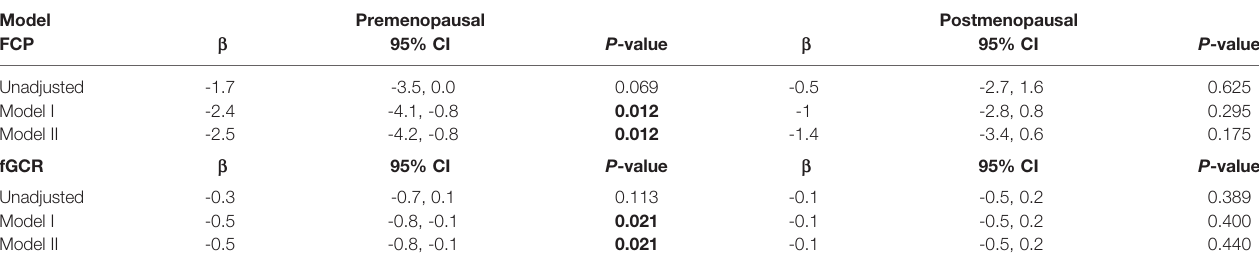
TABLE 7 | Logistic regression used to evaluate the association between 1-mg DST inhibition rate and glucose metabolism in female MACS patients as strati fi ed by menopausal status. Model